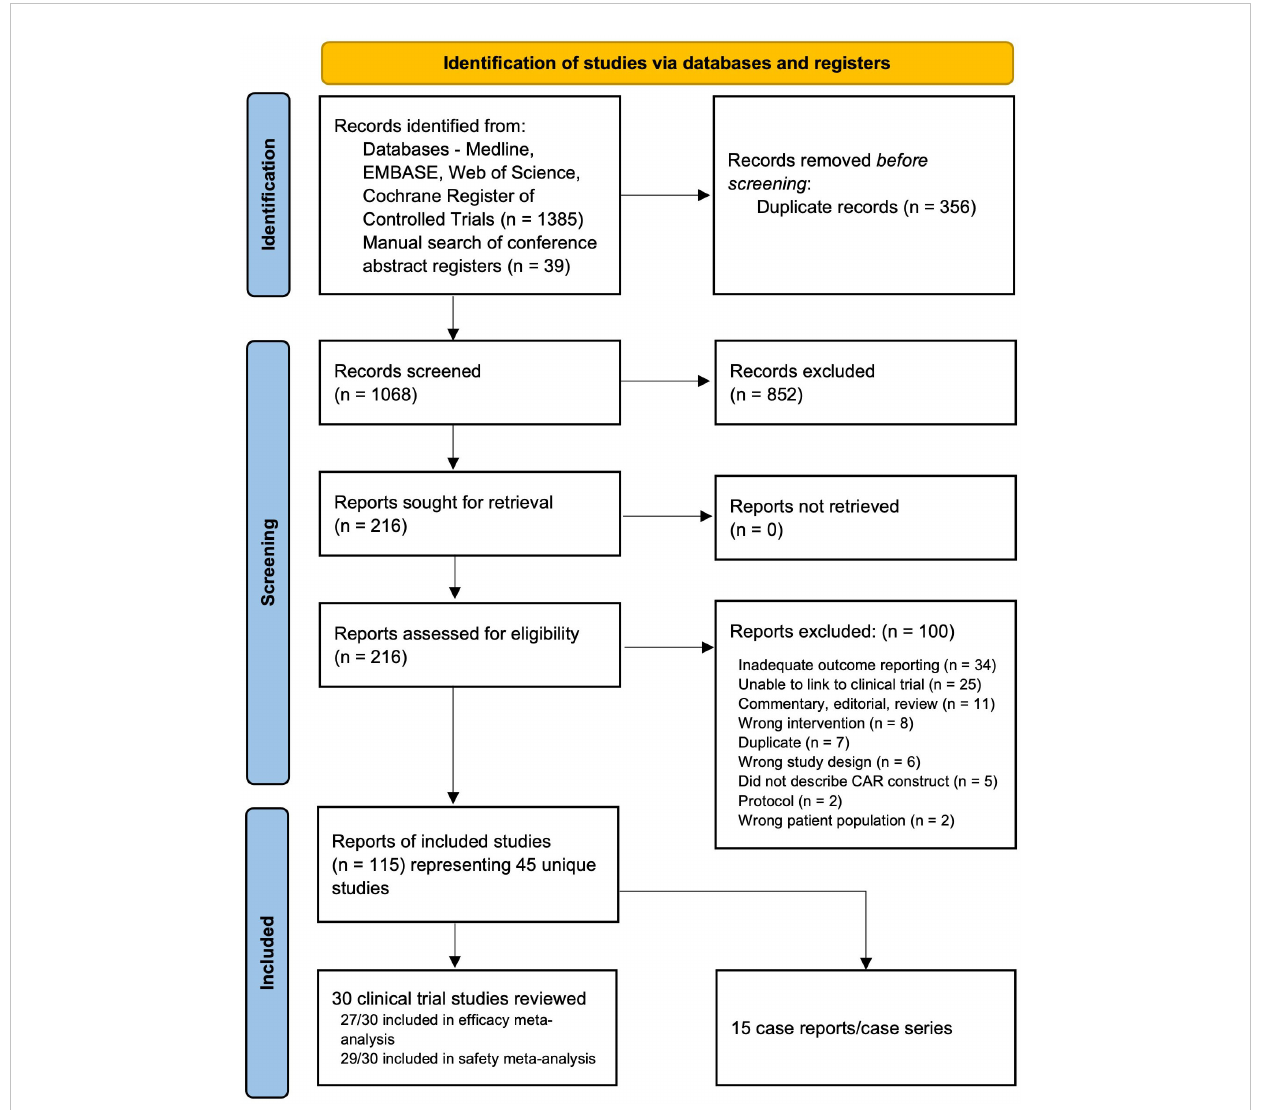
FIGURE 1 PRISMA fl ow diagram of references identi fi ed, screened, excluded (with reasons) and